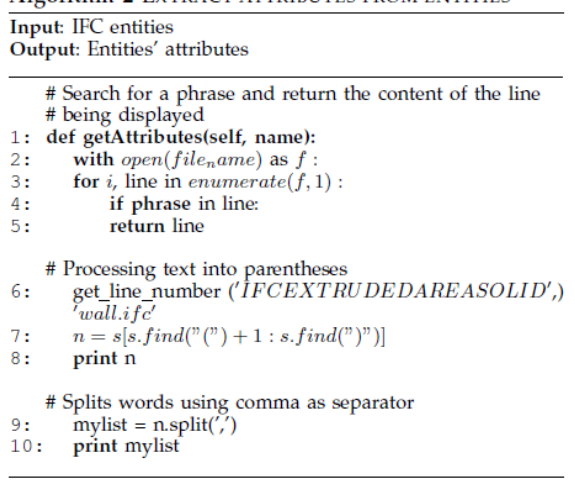
Figure 10: Extract attributes from